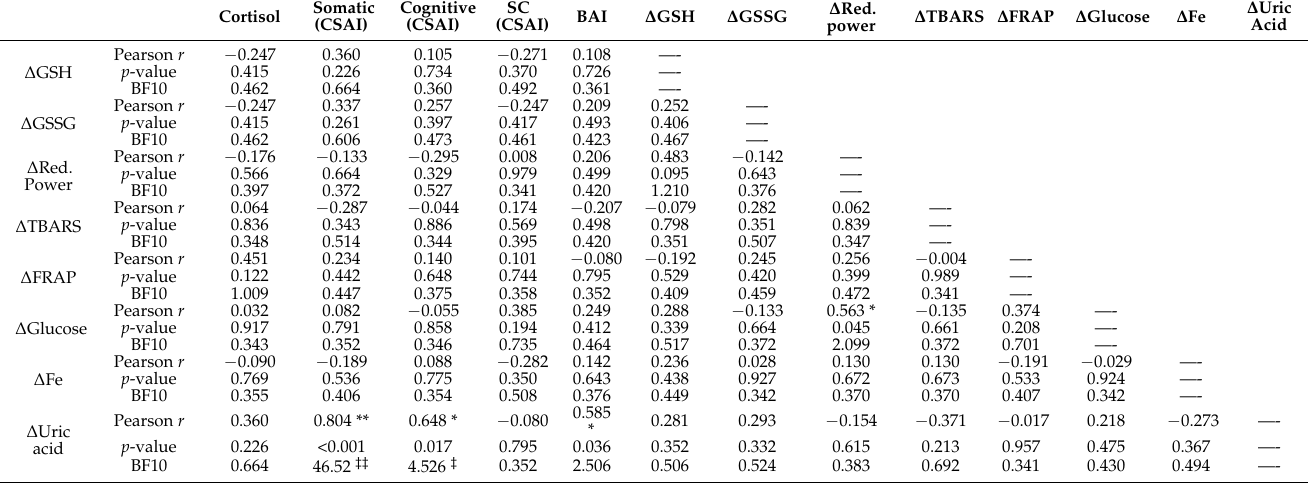
Table 5. Correlation matrix between anxiety scores from CSAI or BAI tests or cortisol levels and the pre/post variation ( ∆ x) of biomarkers of oxidative stress in plasma of novice jiu-jitsu athletes during their first official competitions. (N =